Question: How would you classify this visualization?
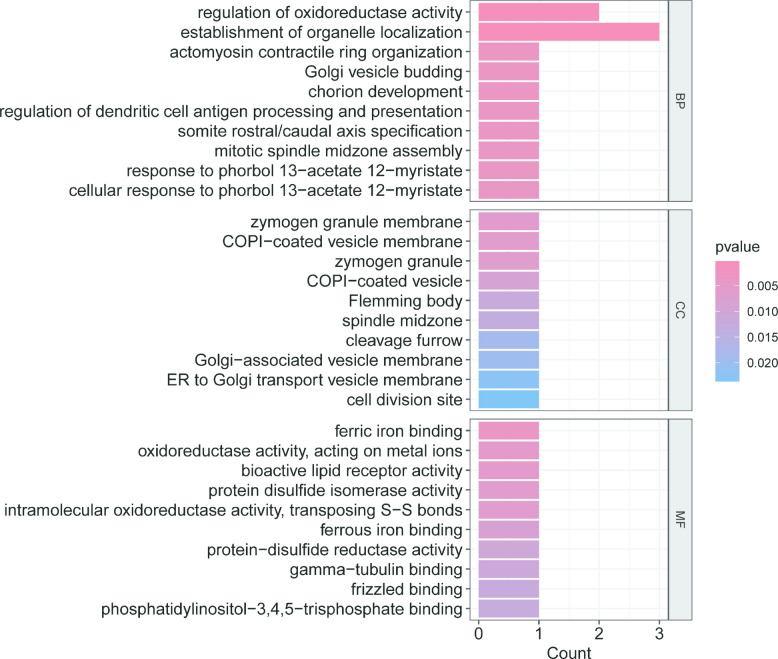
Answer: bar